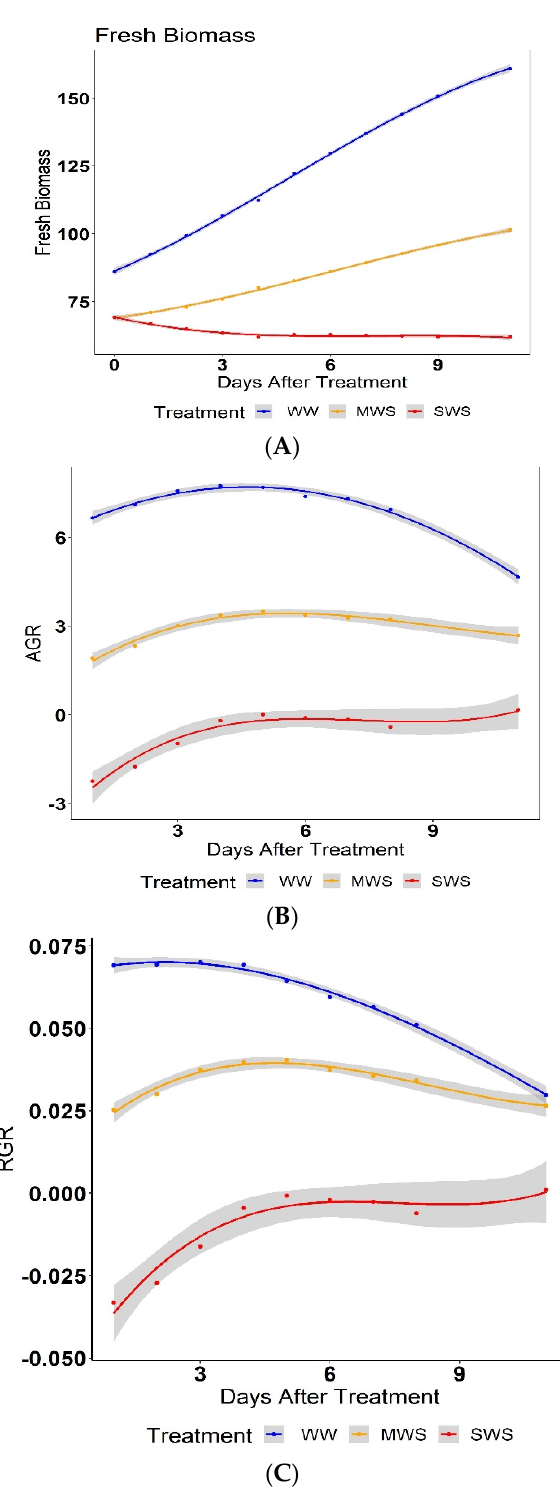
Figure 1. Fresh biomass and growth rates in response to different levels of water stress. ( A ) fresh biomass (g plant − 1 ) was predicted by PLS, based on different image parameters; ( B ) smoothed AGR values (g day − 1 ) and ( C ) smoothed RGR values (g g − 1 day − 1 ) were obtained from the predicted biomass. The solid line represents the grand average of well-watered conditions (blue), moderate water stressed conditions (orange) and severe water stressed conditions (red). Shaded part along the curve displays CI of 0.95.